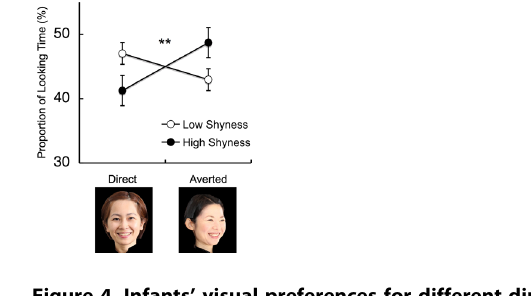
Figure 4. Infants’ visual preferences for different directions of the face and gaze. This figure shows the mean percentile fixation duration for the different types of face stimuli, including strangers’ faces with direct and averted gaze. The bottom pictures are examples of the face stimuli. The open and filled circles represent the mean fixation durations for the infants with low and high shyness, respectively. **P , 0.01. Error bars indicate the S.E. of the mean.